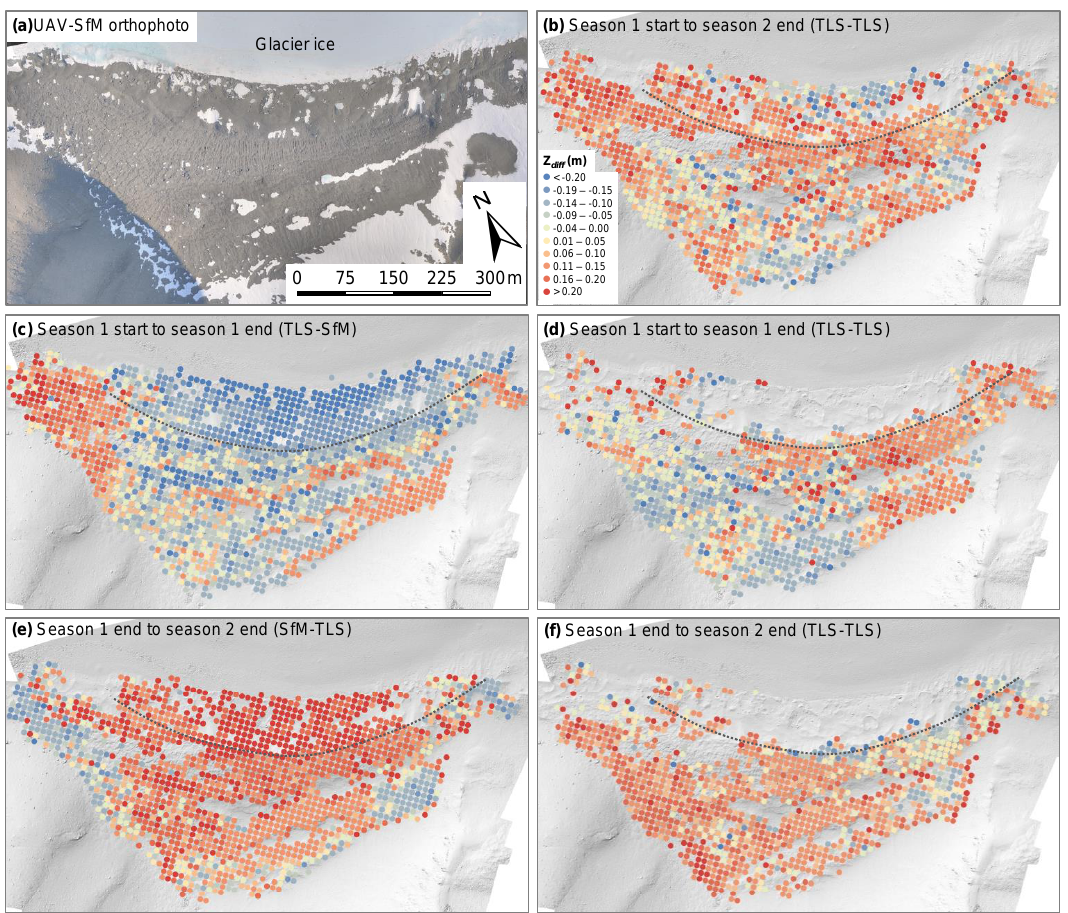
Figure 5. Vertical component of 3-D topographic change ( Z diff ) overlain on a UAV-SfM-derived hill-shaded DEM of the Patriot Hills blue- ice moraine complex. Topographic evolution was quantified using the Multiscale Model to Model Cloud Comparison (M3C2) algorithm in CloudCompare software. Vertical change is represented as the mean of significant change beyond a threshold of ± 0.103m within 10m 2 grid cells. (a) UAV-SfM orthophotograph of the study site. Panels (b) to (f) cover specific differencing epochs using a combination of TLS and SfM data (see panel headings). Dashed line in (b) to (f) indicates locations of primary moraine ridge